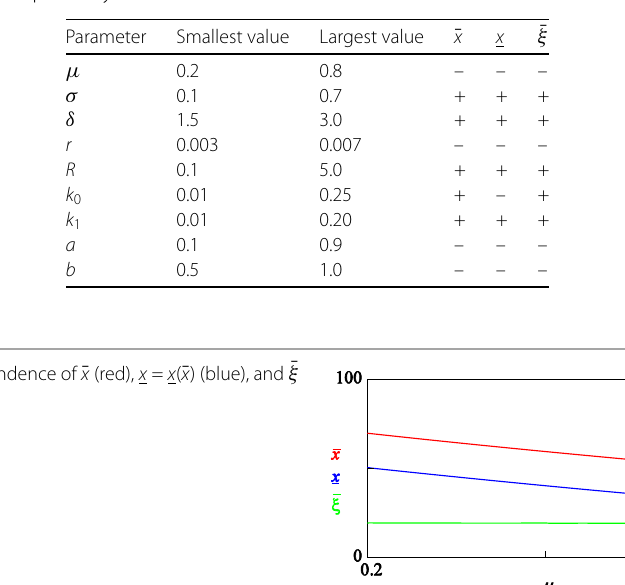
Figure 5 Dependence of ¯ x (red), x = x ( ¯ x ) (blue), and ¯ ξ (green) on σ